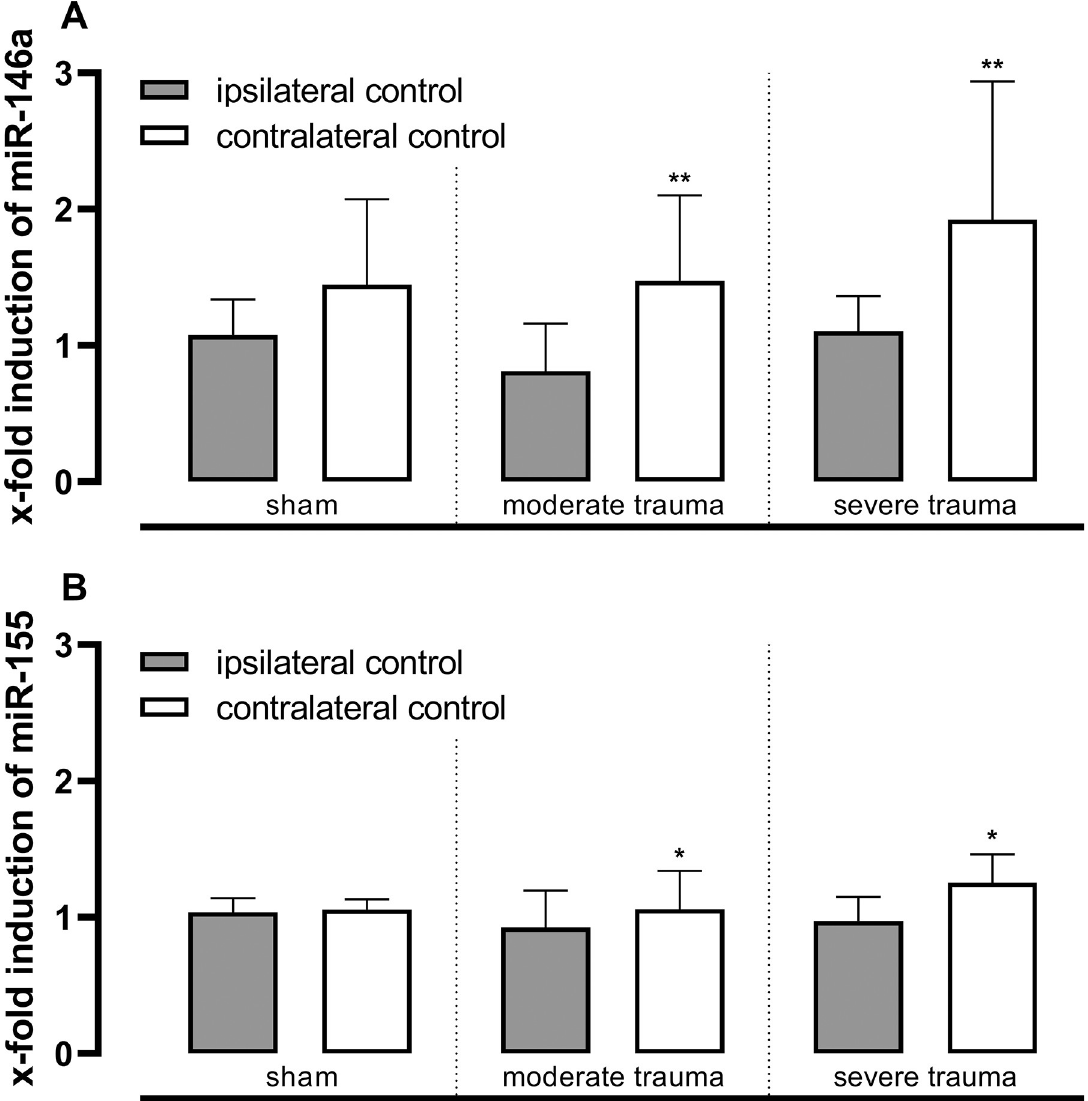
Fig 5. Trauma-distant activation of inflammatory response regulators in the non-injured left lung. Expression of microRNA-146a and microRNA-155 [x-fold]. Lung tissue homogenates from the right upper lobe (ipsilateral control) and the non-injured left upper lobe (contralateral control) were analyzed by RT-qPCR, logarithmic data were normalized to microRNA-17. Mean (SD) values on linear scale are shown. Statistical analysis: Mann-Whitney test: � p � 0.05, �� p � 0.01. Detailed information including sample counts are provided in S6B Table in S1 File